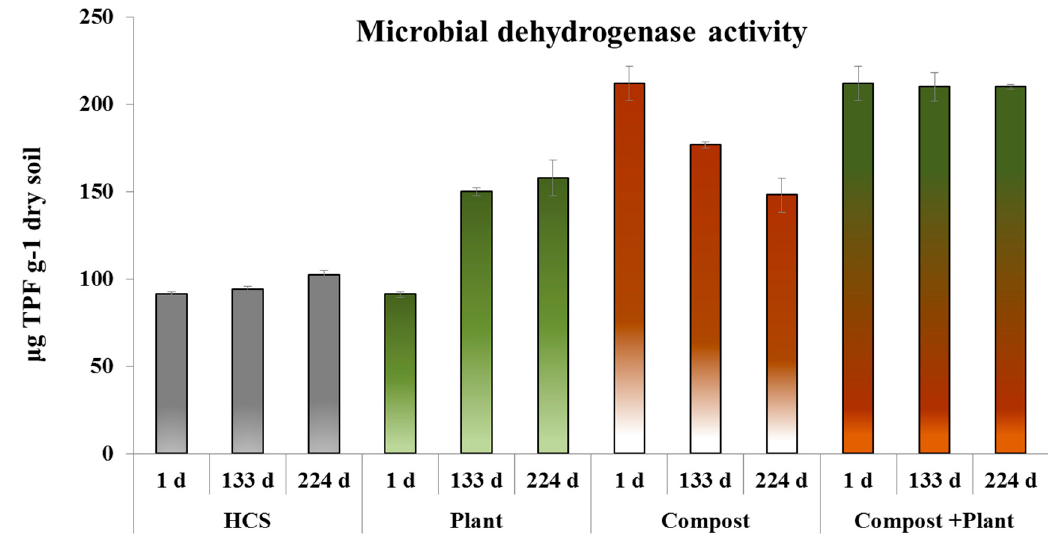
Figure 5. Microbial dehydrogenase activity ( µ g TPF g − 1 dry soil) over time (days 1, 133 and 224). HCS: historically contaminated soil; Compost: historically contaminated soil amended with municipal solid waste compost; Plant: historically contaminated soil with Medicago sativa plant; Compost + Plant: historically contaminated soil amended with the compost, in the presence of Medicago sativa plant. The vertical bars represent the standard errors.